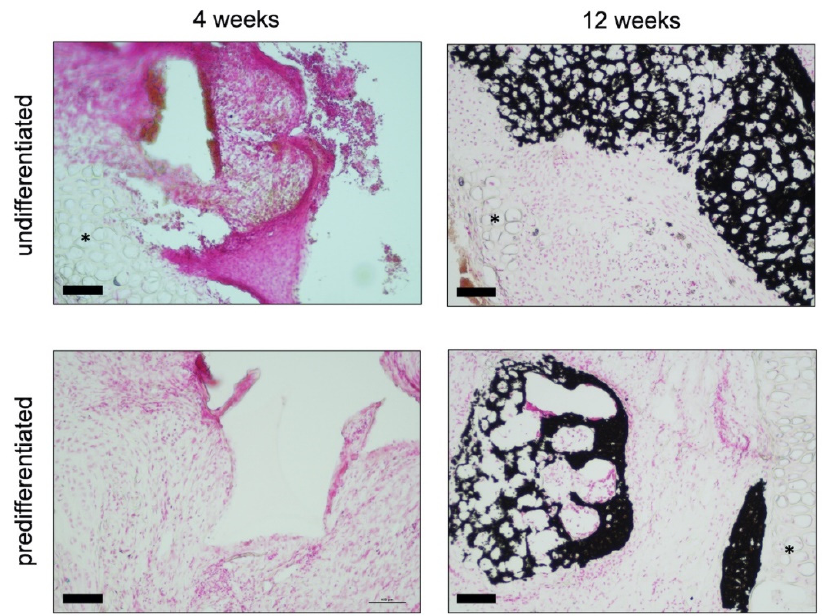
Figure 8. Von Kossa staining of cell-seeded PU-fibrin composites in vivo (New Zealand White Rab- bit): The native auricular cartilage in the region of the defect margin is highlighted with asterisks